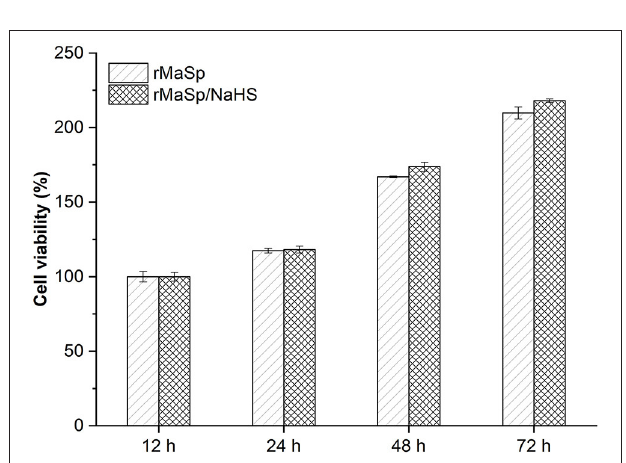
FIGURE 5 | NIH 3T3 cell viability tests when cells were cultured on rMaSp membrane and rMaSp/NaHS membrane for 12–72h, showing no significant difference in cell